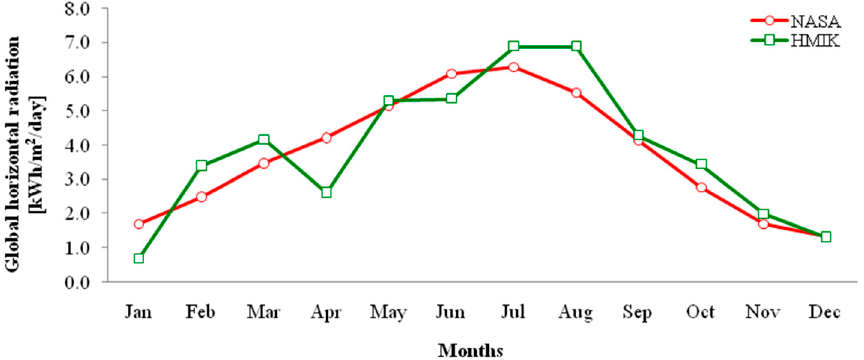
Figure 6. Comparison of global horizontal radiation data collected from a satellite (NASA) and measured by HMIK for the time period 2003–2013.